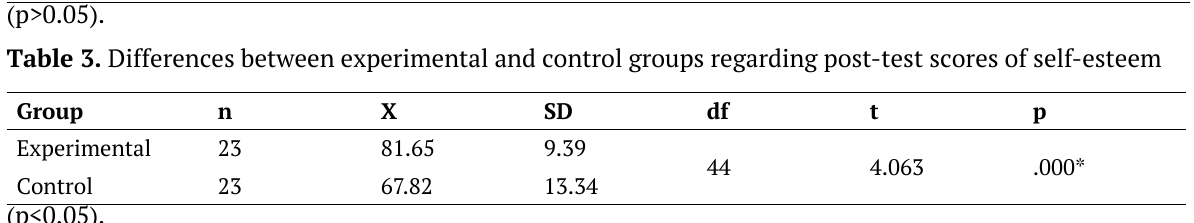
Table 2. Differences between experimental and control groups regarding pre-test scores of self-esteem Group n Experimental